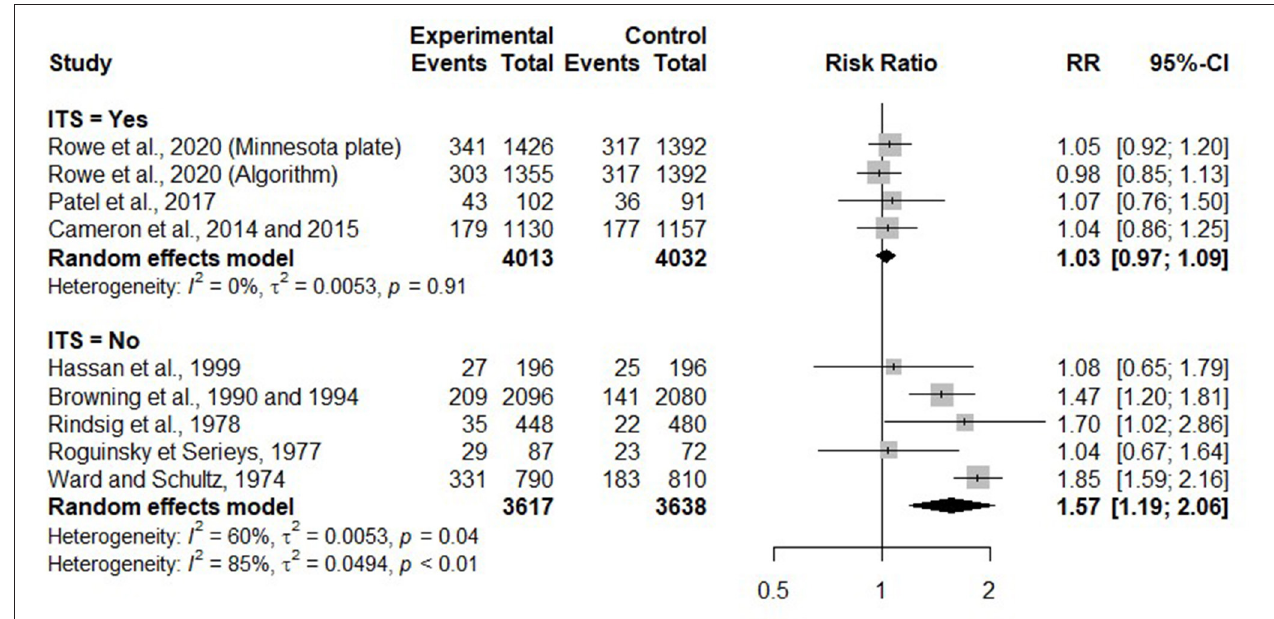
FIGURE 6 | Forest plots showing the effect of selective dry cow treatment compared with blanket dry cow therapy on risk of IMI prevalence at calving.